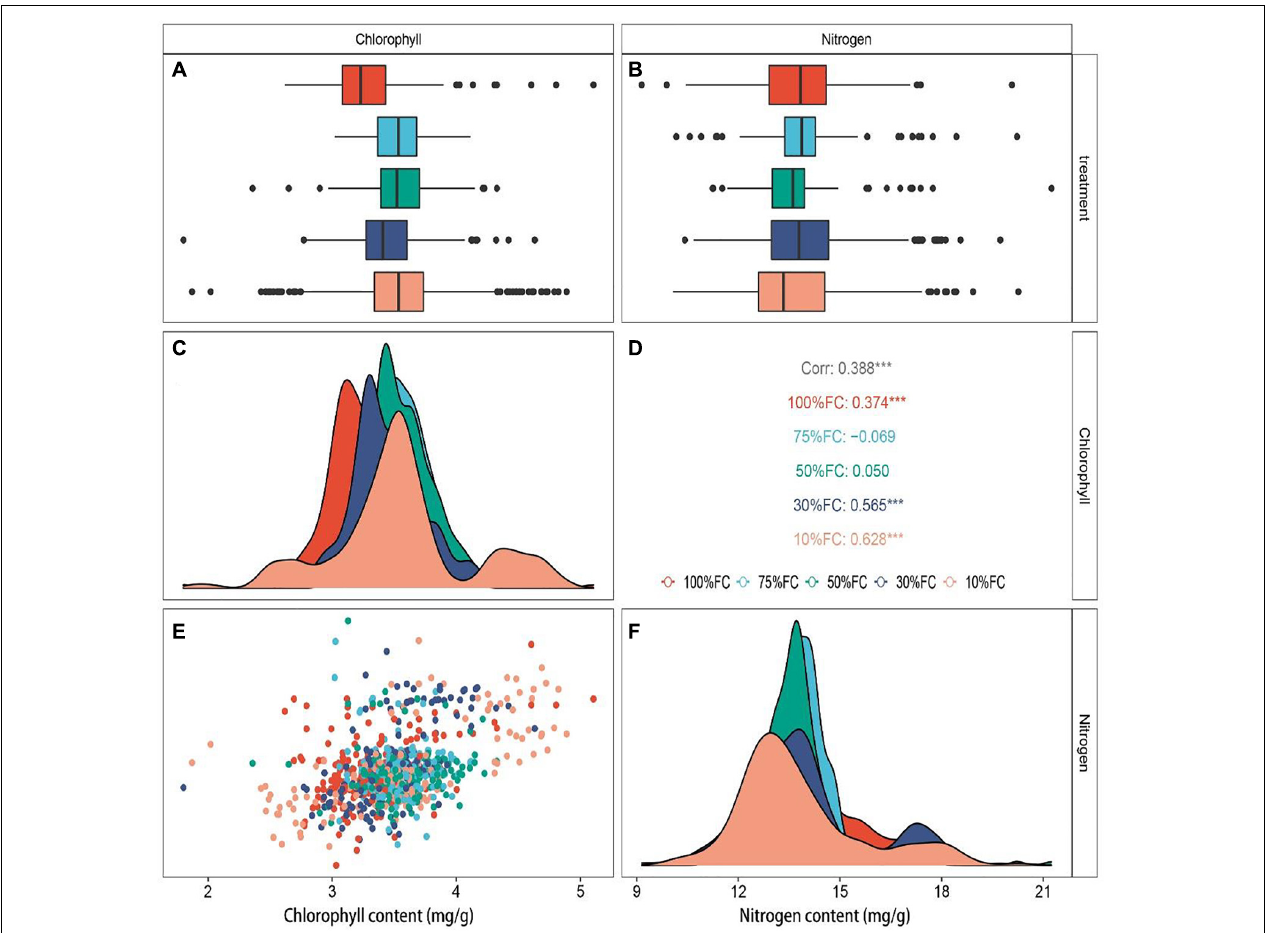
FIGURE 6 | Chlorophyll (A) and nitrogen (B) content under separate drought treatments. Correlation analysis of chlorophyll and nitrogen content of T . sinensis leaves under separate drought treatments (D) . Chlorophyll (C) and nitrogen (F) content were normally distributed. Distribution map of chloroplast content of all samples (E) . Statistical significance was determined by two-tailed t -test with equal variance comparing the unique drought treatments of chlorophyll and nitrogen content; *** p < 0.001. Different colors indicate separate treatments, and the corresponding colors are the same as the above